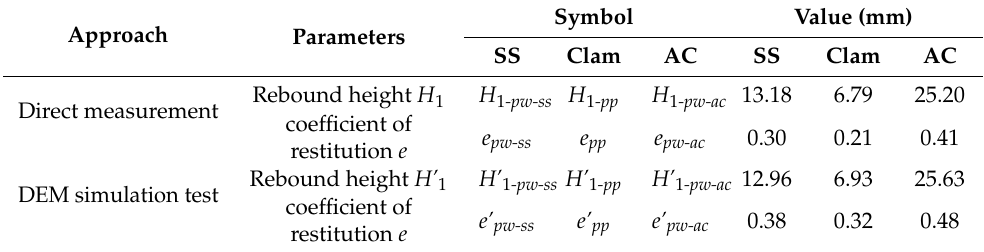
Table 3. The coefficient of restitution ( e ) for SS, AC, and